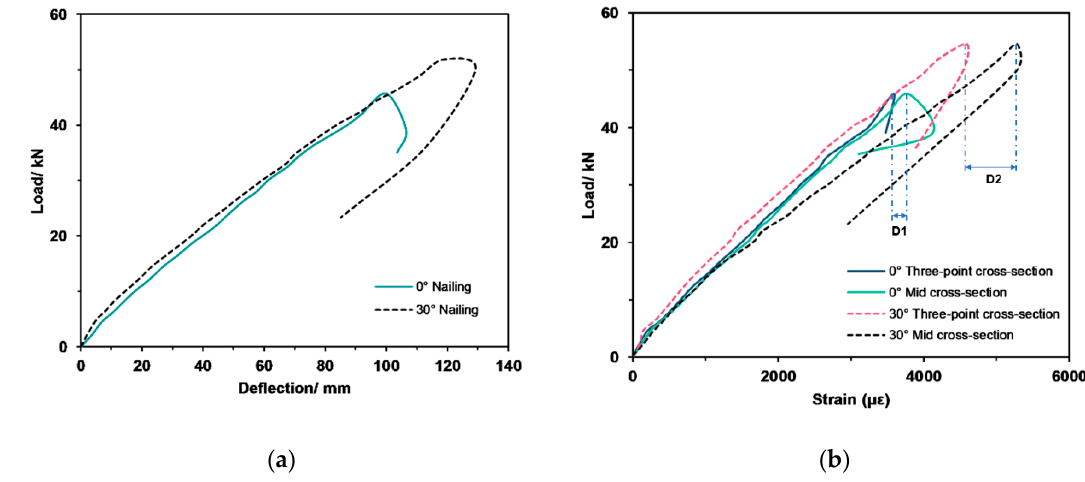
Figure 9. Effect of nail penetration angle on load ‐ deflection and load–strain relationship. ( a ) Load– deflection curve; ( b ) Load–strain curve.